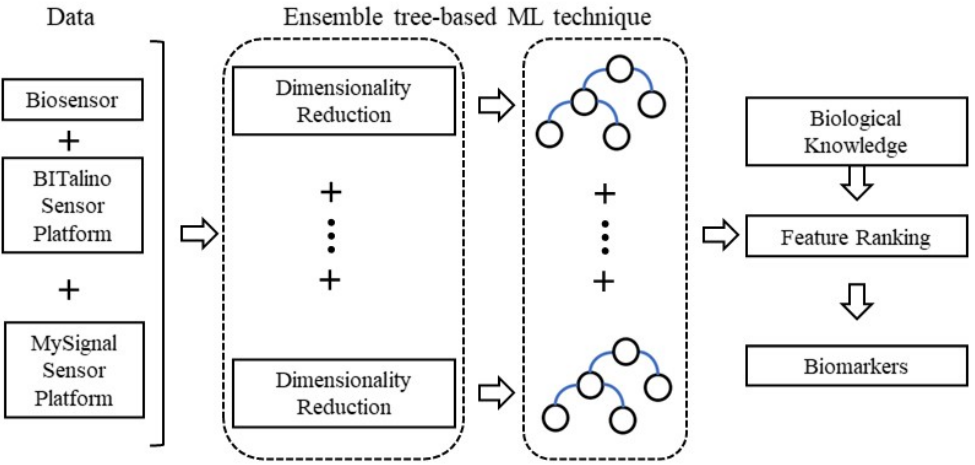
Figure 2. A proposed framework for early-stage PD detection using ensemble learning with dimen- sionality reduction methods.